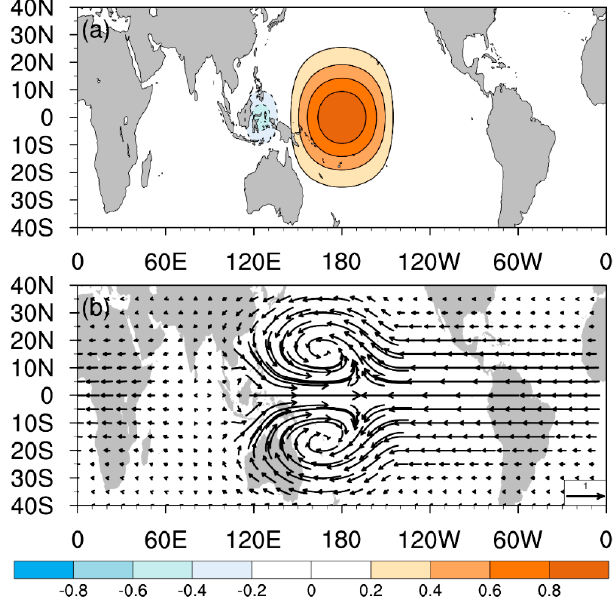
Figure 6. ( a ) Distribution of the prescribed ideal heating and cooling for the Matsuno-Gill model. The location of the prescribed ideal heating (cooling) source is consistent with the distribution of maximum positive (negative) precipitation anomalies during JAS, with strength decreasing from the center to the surroundings. ( b ) Analytical solutions for horizontal winds forced by the heating and cooling in ( a ).